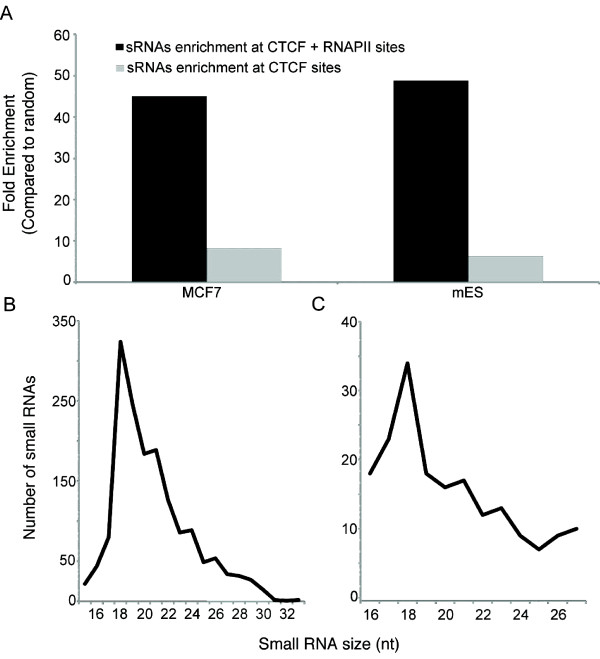
Enrichment of transcription initiation (ti)RNAs at CCCTC-binding factor-RNA polymerase II (CTCF-RNAPII) sites in human MCF-7 and mouse embryonic stem (mES) cells. (a) Enrichment of tiRNAs at CTCF sites in MCF-7 and mES cells compared to 1,000 simulated random distributions. (b, c) Size distribution of tiRNAs that intersect CTCF-RNAPII sites in MCF-7 and mES cells.